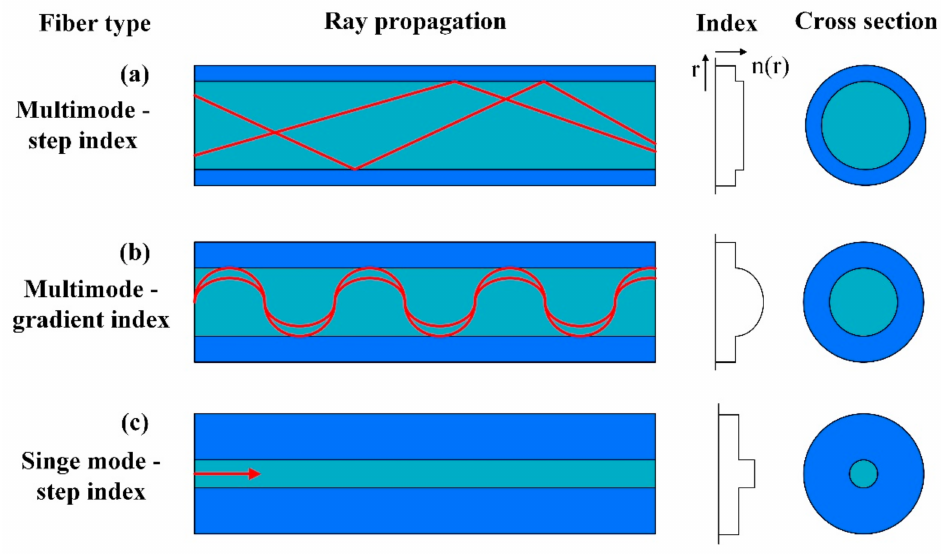
Figure 2. The common structures of